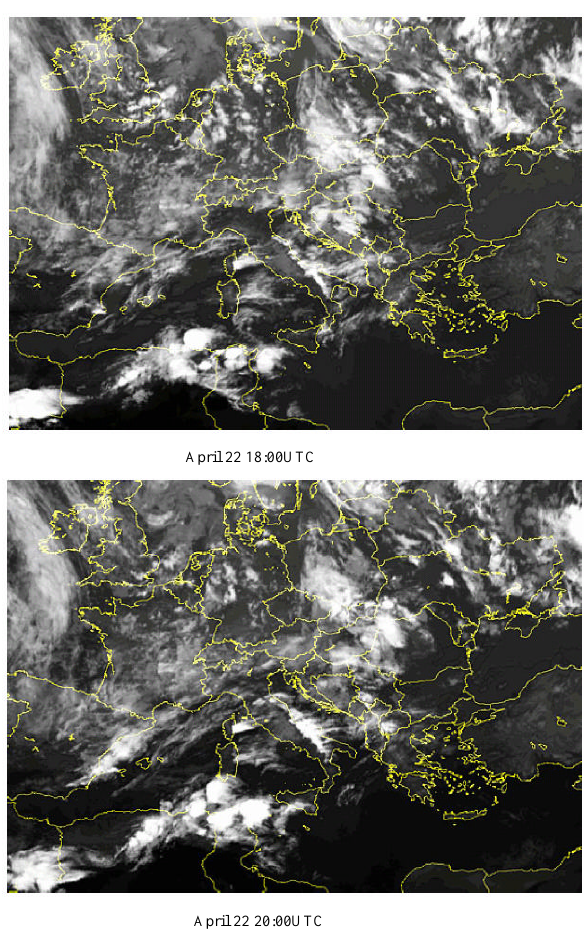
Fig. 1. Geostationary satellite image of Europe from 22 April 18:00 UTC to 23 April 02:00 UTC.